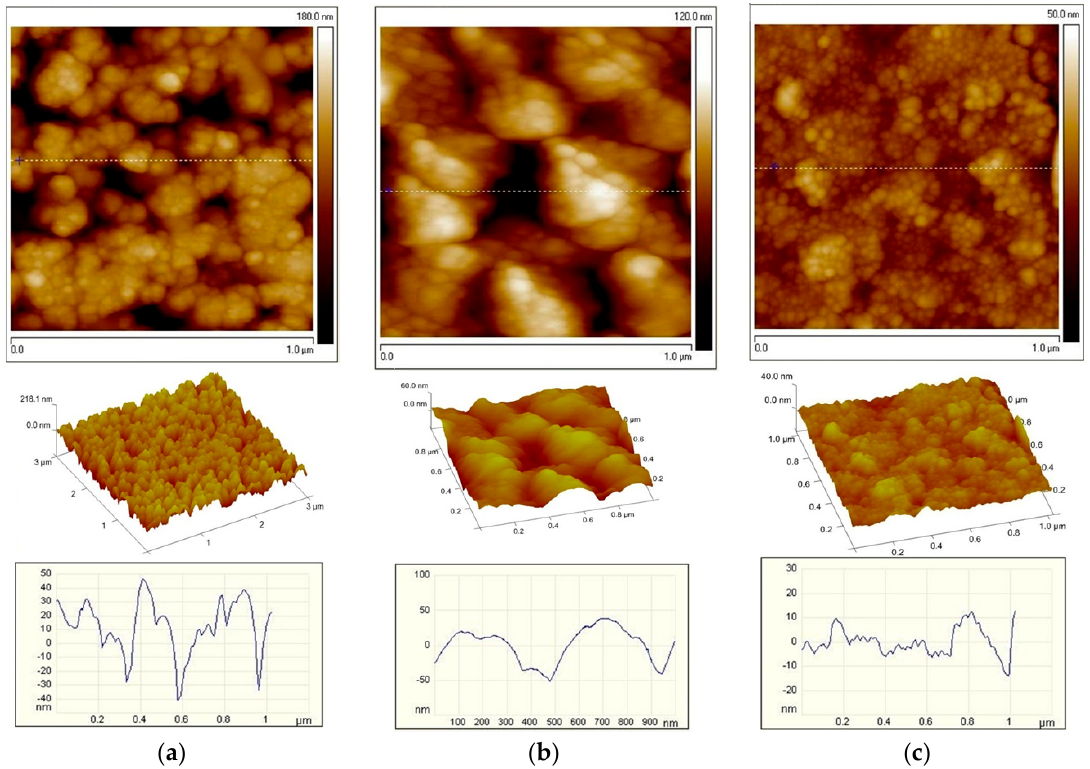
Figure 4. Atomic Force Microscopy (AFM) image of the PZT film surface: ( a ) without a PbO sublayer; ( b ) with 10 nm PbO thick sublayer; ( c ) with 20 nm thick PbO sublayer. 210